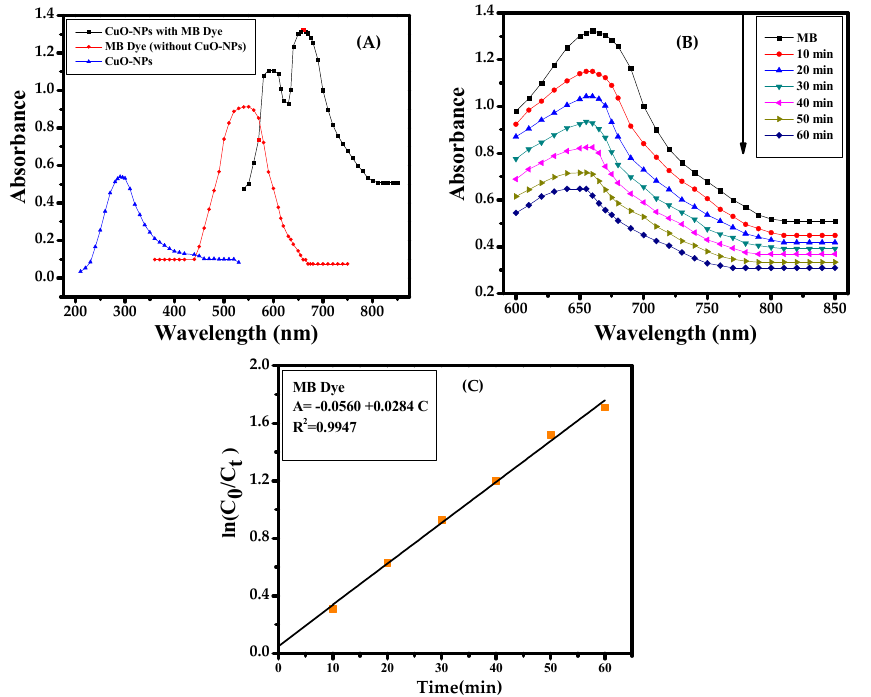
Figure 2. ( A ) UV spectra of methylene blue (MB) dye with CuONPs; ( B ) catalytic reduction of MB dye with CuONPs and ( C ) calibration plot of ln( C 0 / C t ) vs. time for the photodegradation of MB dye.